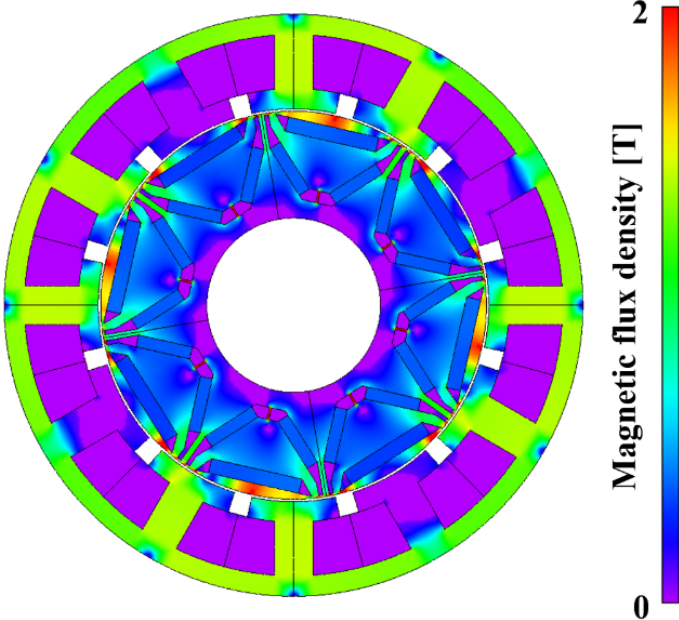
Figure 7. Load condition magnetic flux density contour plot of the optimum model. Table 4. Optimization result and performance comparison of the initial model and optimum model.